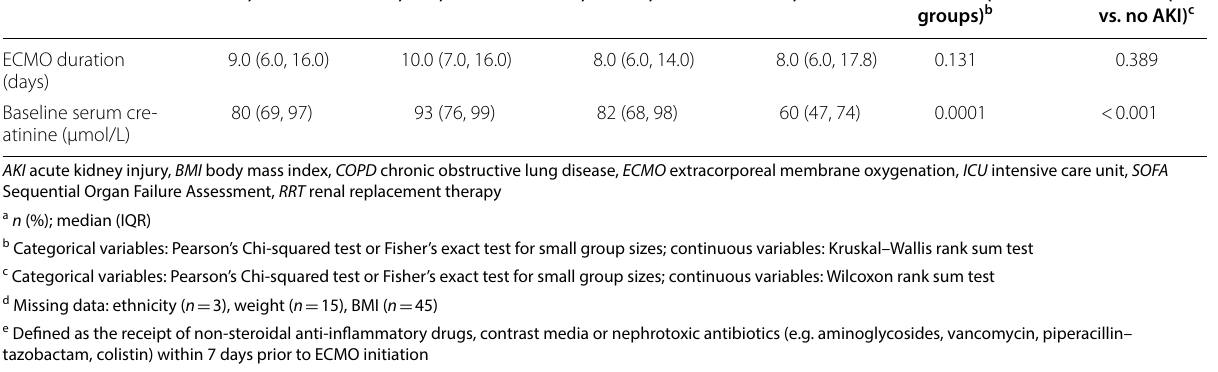
Table 2 In-hospital outcomes by acute kidney injury and renal replacement therapy status